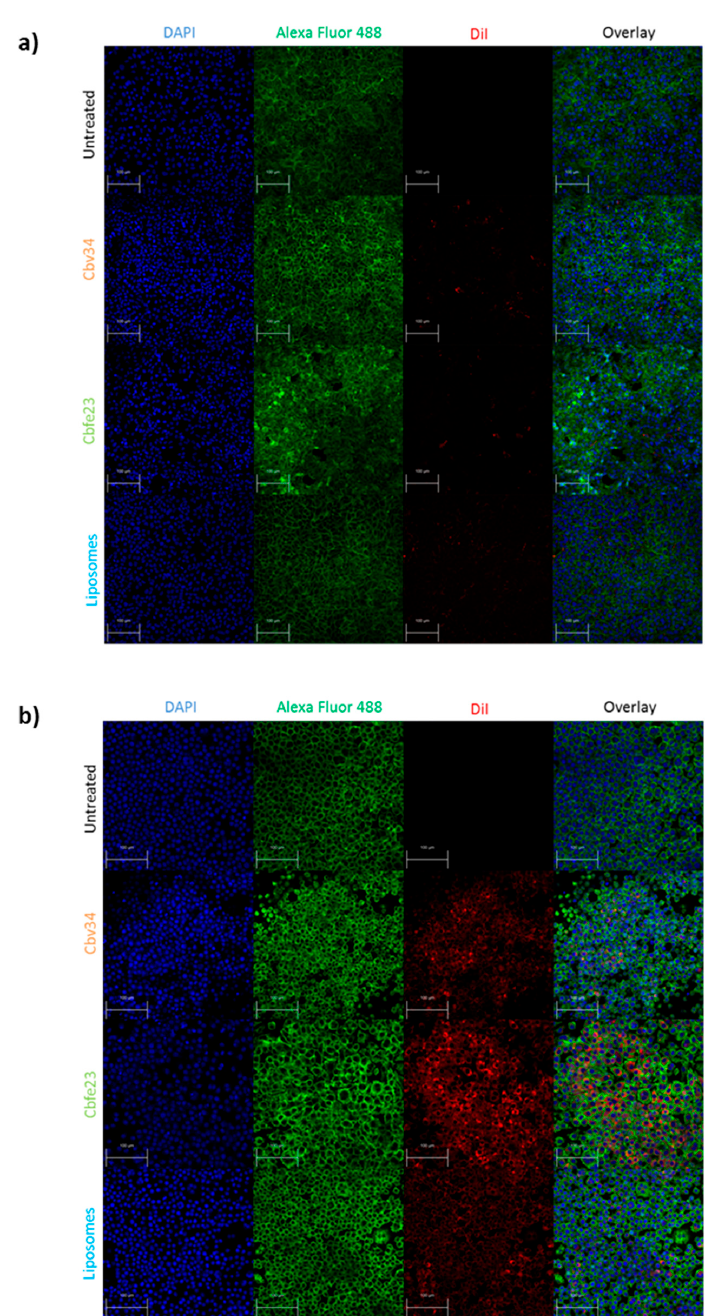
Figure 8. Uptake of fluorescent particles investigated by confocal laser scanning microscopy (CLSM) after 24 h of incubation with ( a ) A549 and ( b ) RAW 264.7 cells. The cells nuclei are stained with DAPI (blue), while the F-actin is labelled with Alexa Fluor 488 Phalloidin (green). OMVs and bacterial liposomes are stained with DiI (red). Scale bar = 100 μ m.